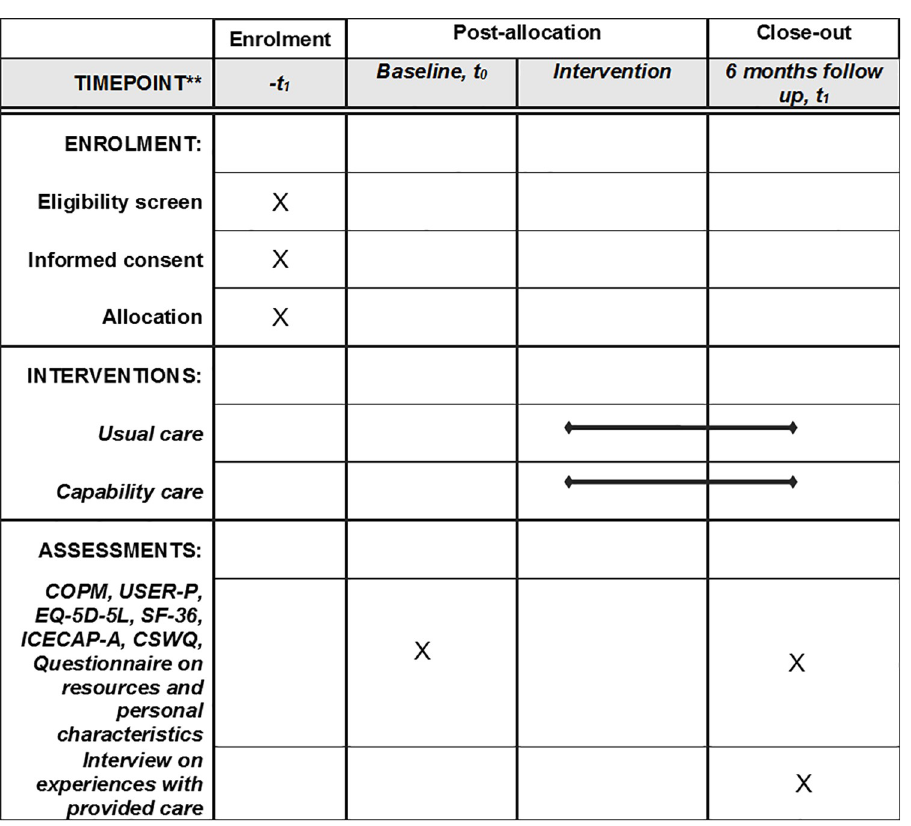
Fig 1. SPIRIT schedule of enrolment, interventions, and assessments.